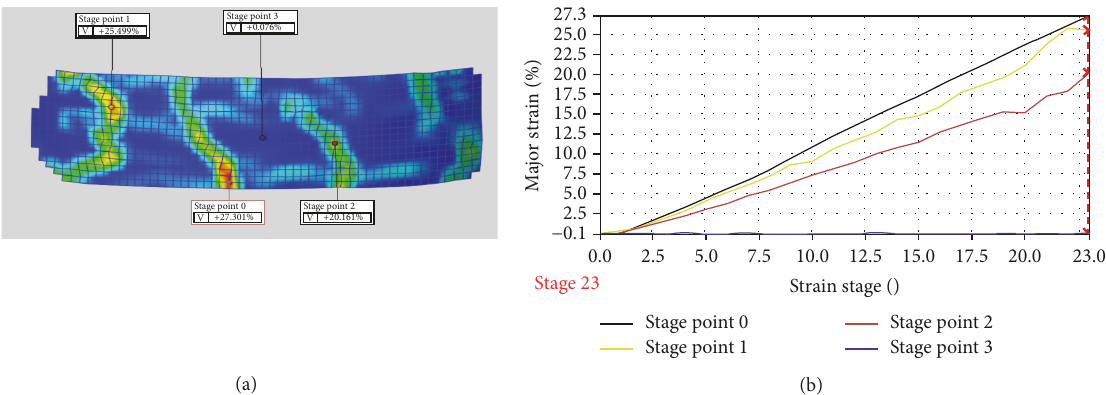
Figure 9: Locations of the four selected feature points on the surface of the mudded weak interlayer specimen (a) and the monitoring results of the major strain (b).